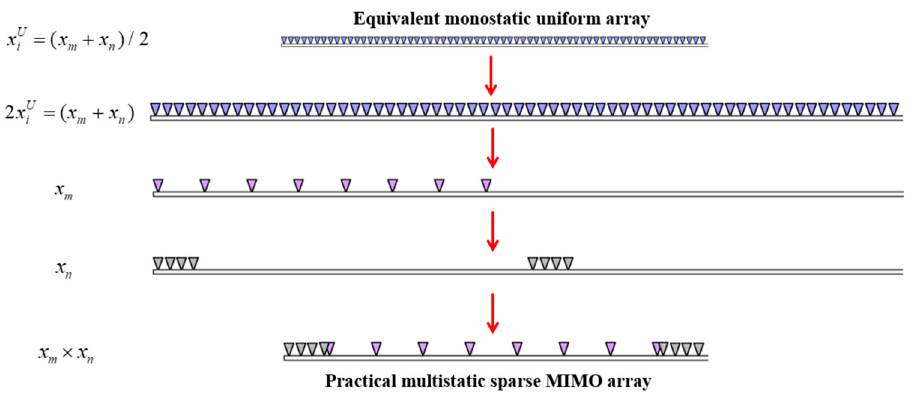
Figure 3. Schematic diagram of the polynomial factorization (PF) method.